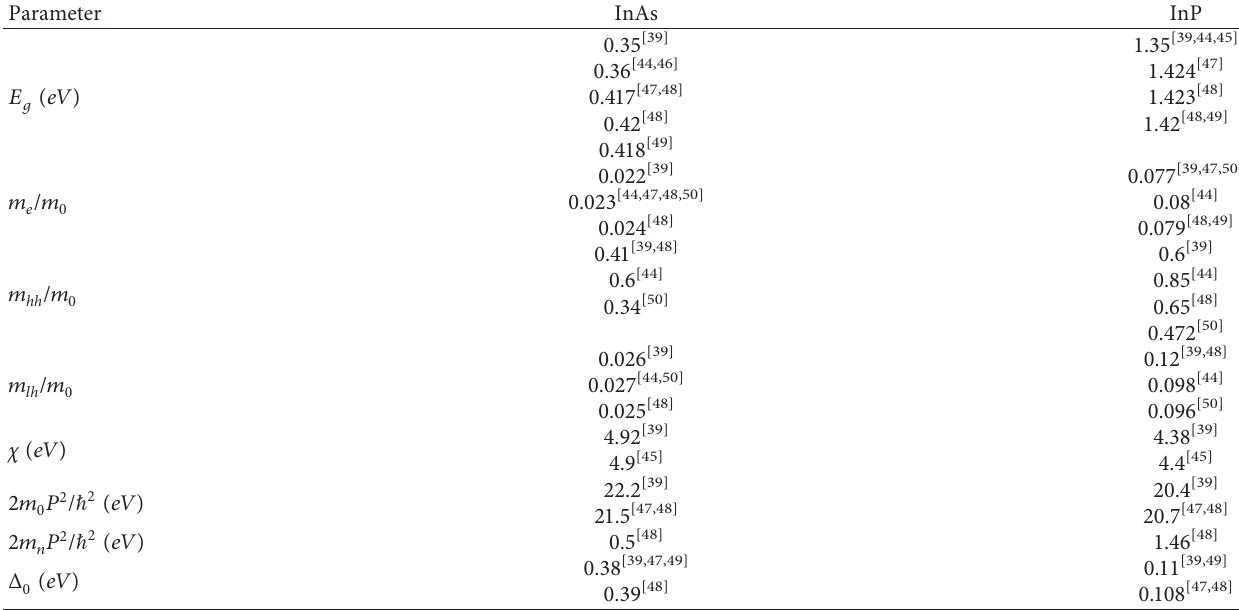
Table 1: Material parameters of InAs and InP.